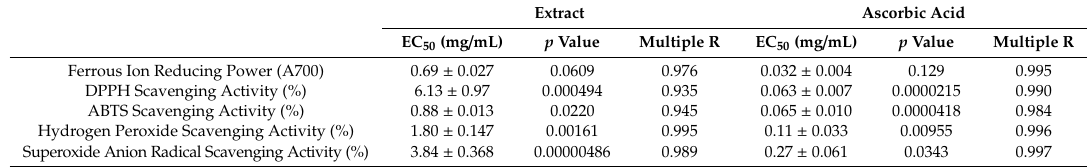
Table 5. EC 50 and correlation analysis between antioxidant activities and content of extract and ascorbic acid.